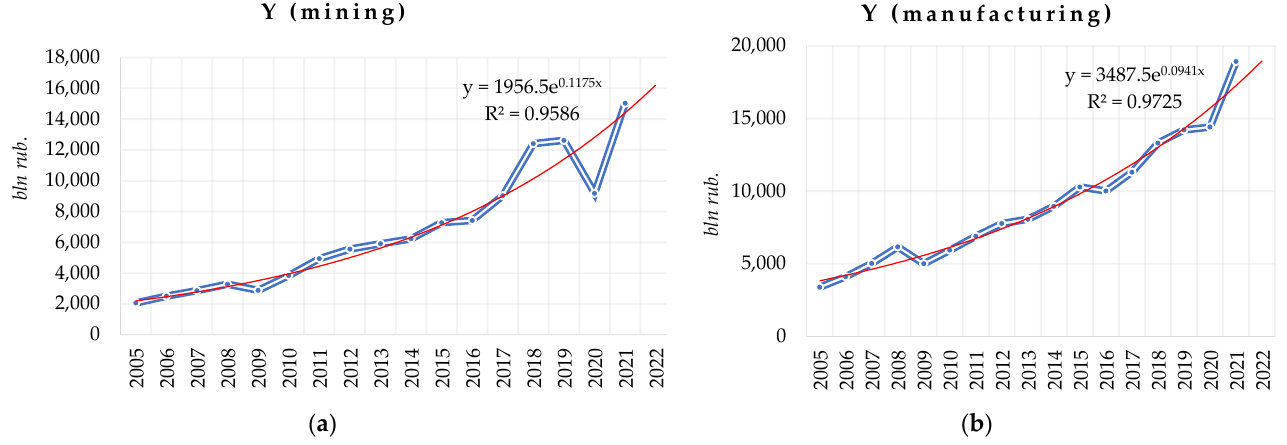
Figure 3. Extrapolation of gross value added by industrial sector of the Russian economy by con- structing an exponential trend line for the mining ( a ) and manufacturing ( b ) industries.